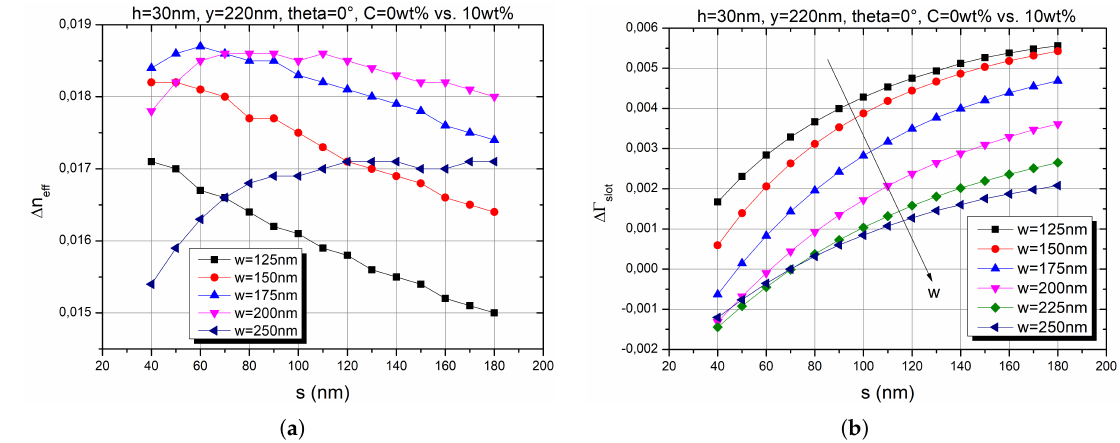
Figure 8. Difference in the effective refractive index ∆ n eff ( a ) and the field confinement factor ∆Γ slot ( b ) of both concentrations as a function of s , with w as